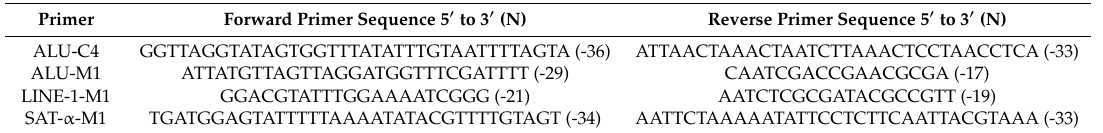
Table 1. Primers information